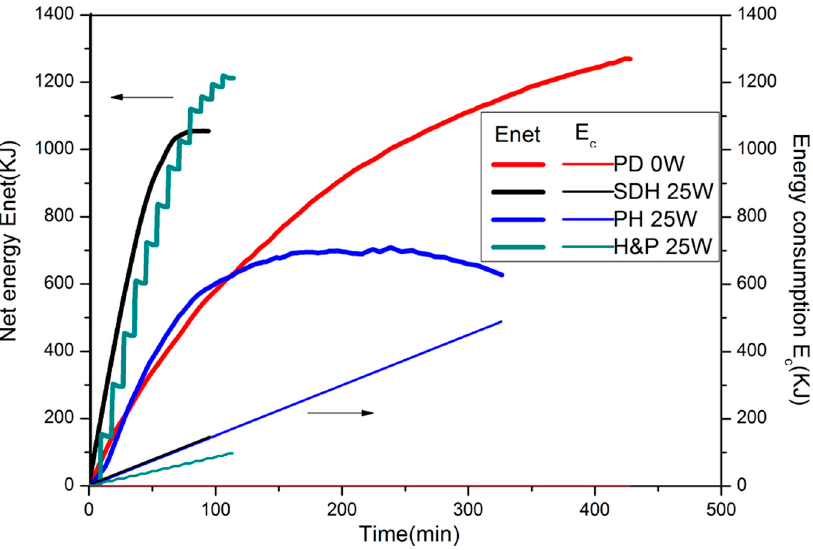
Figure 7. The curves of net energy ( E net ) and the total energy consumption ( E C ) of four runs in the production stage.